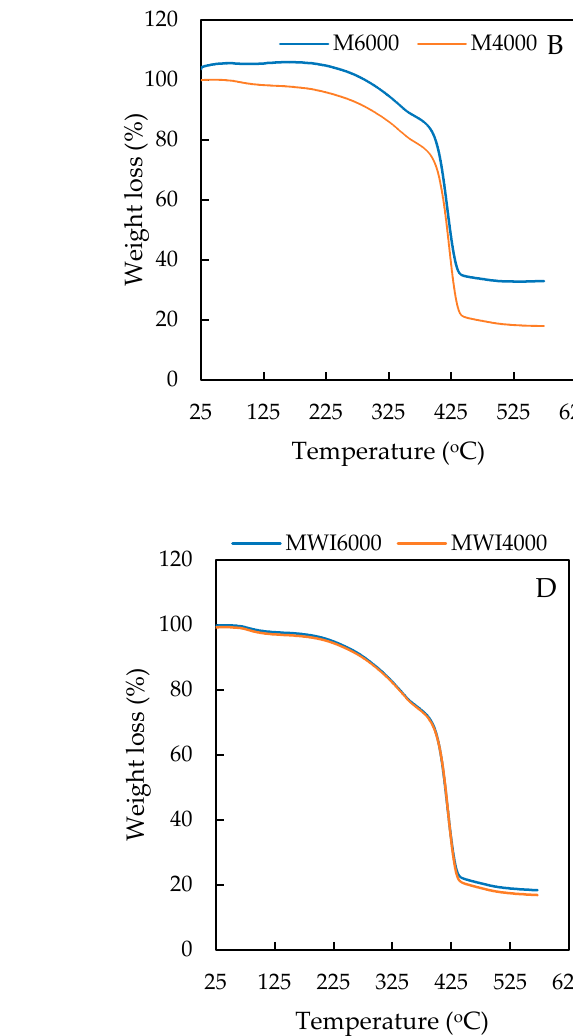
Figure 7. Thermogravimetric curves of MOLP solid dispersions prepared through ( A ) freeze-drying method (FD4000 and FD6000), ( B ) melting method (M4000 and M6000), ( C ) solvent evaporation method (SE4000 and SE6000), and ( D ) microwave method (MWI4000 and MWI6000).